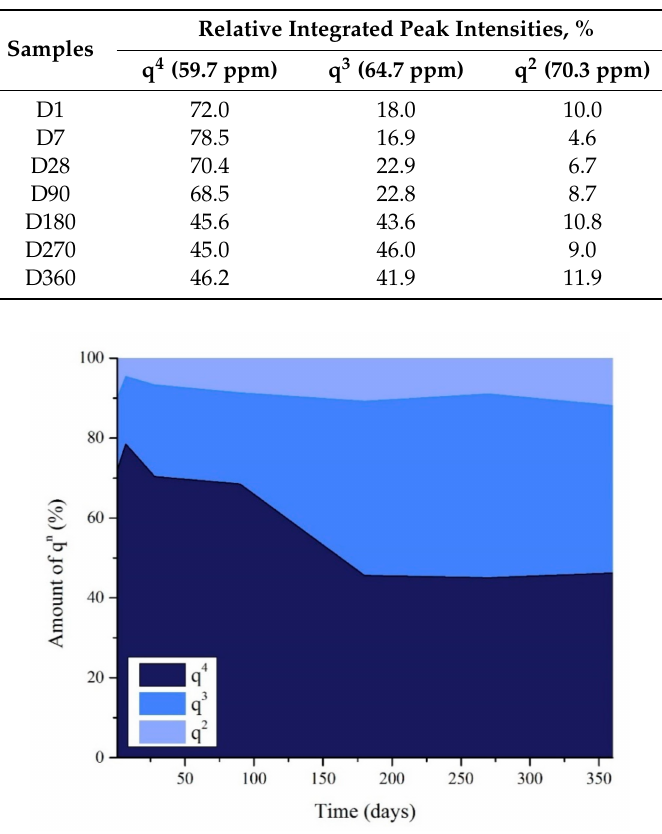
Figure 8. Deconvolution of the 27 Al NMR spectra of the pore solution with age of 1 day. Table 2. 27 Al NMR chemical shifts and relative integrated intensities of q n site Al from deconvolution of the 27 Al NMR spectra for pore solution.